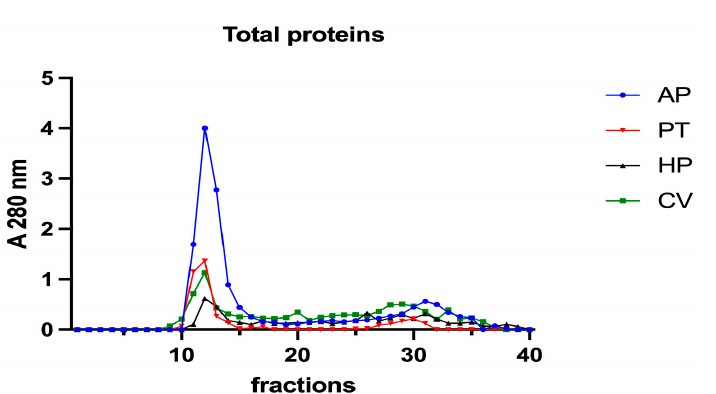
Figure 3. Chromatographic profiles of total proteins after SEC of extracts from algal samples. Proteins were detected at 280 nm. Each chromatographic profile is the mean of two chromatographies. AP = A. platensis; PT = P. tricornutum; HP = H. pluvialis; CV= C. vulgaris.